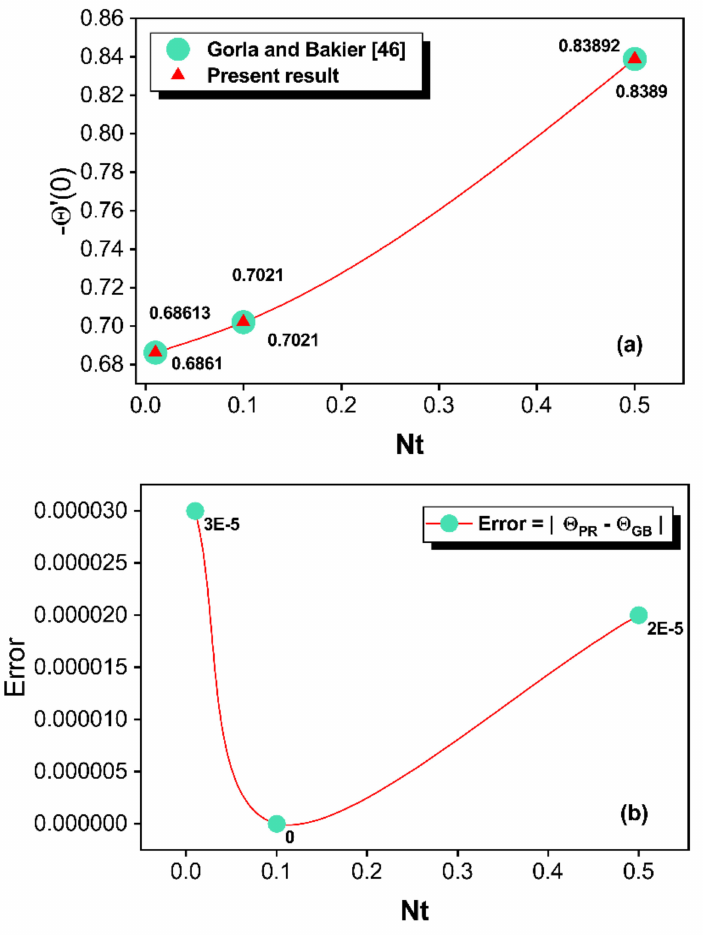
Figure 2. ( a , b ) Comparison of the results and error estimations. The primary difference between solid and porous fins is the presence of an extensive number of pores involved with the permeable fin, which permits liquid to flow via these holes. Based on the current examination, Figure 3 is designed to demonstrate the thermal distribution and heat transfer rate in porous and solid dovetail fins as a component of fin length. At X = 0, the thermal profile for both solid and porous dovetail fins attain their maximum value, and the temperature profile shows decreasing characteristics as the X ranges from 0 to 1. In other words, the temperature is maximum at the fin base and gradually reduces from there to the tip. Finally, there will be less temperature distribution at its tip. The porous fin has a lower thermal distribution than that of the solid fin owing to the occurrence of a large number of pores that allow fluid to flow through the holes. Consequently, a porous fin offers a greater rate of heat transmission than is achieved with a solid